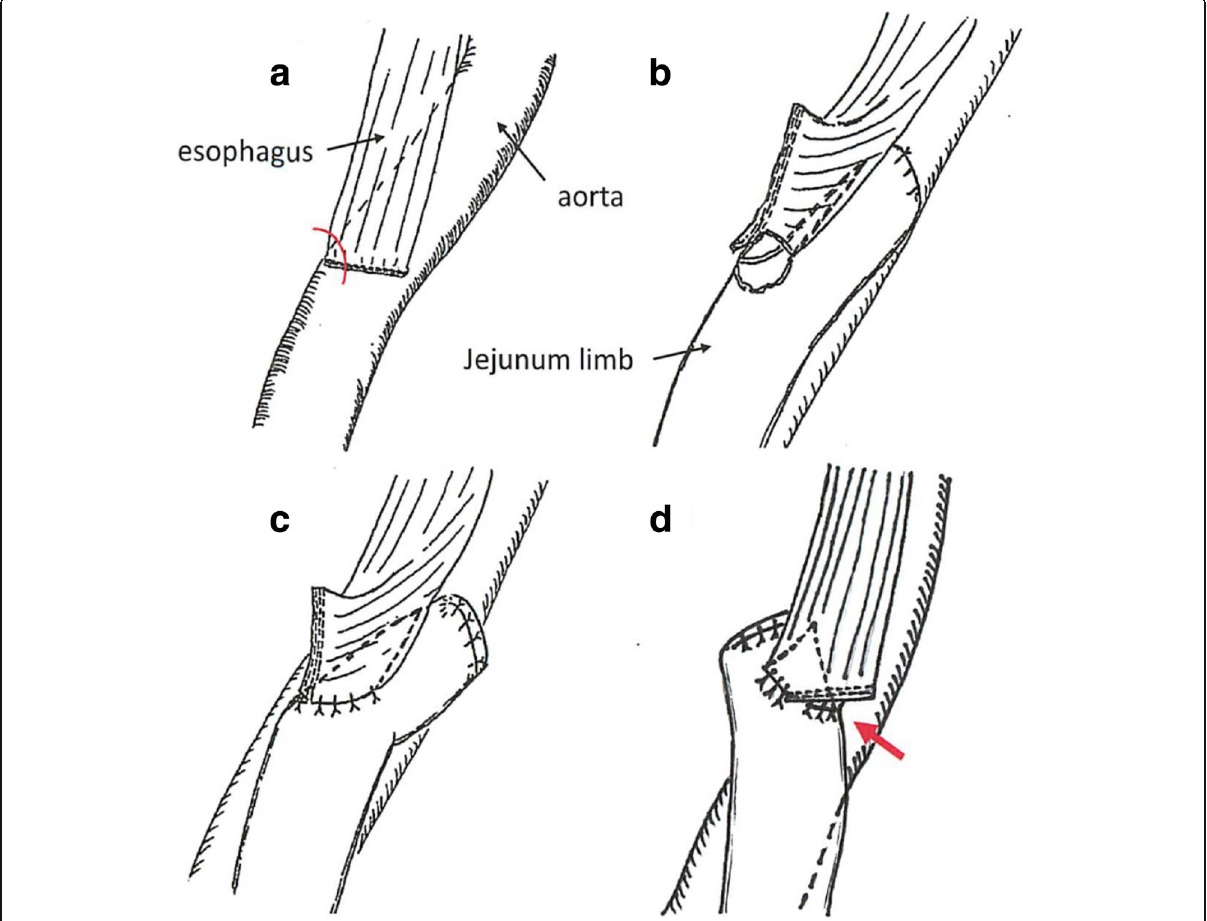
Fig. 1 Schematic diagram of overlap esophagojejunostomy. a Latitudinal dissection of the esophagus via a left 8th intercostal trocar with linear stapler to obtain a safety margin. The right side of the stapled edge was cut. b Creation of side-to-side anastomosis created with the linear stapler between the right side of the esophagus edge and the jejunal limb, after which the jejunal staples were covered by seromuscular sutures extracorporeally. c The communication hole was closed using an interrupted hand-sewn technique. d The dorsal edge of the stapler was in contact with the bare thoracic aorta